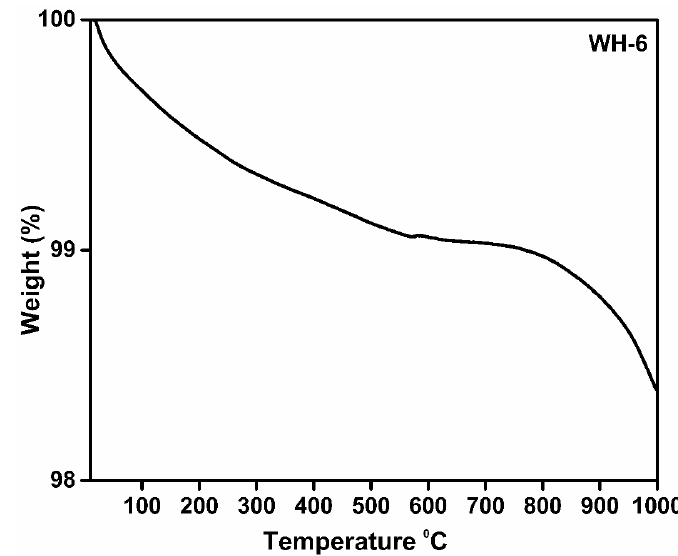
Figure 8. TGA graph of WH-6 product.